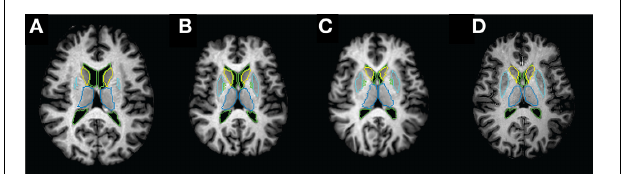
FIGURE 1 | Example axial slices of atlas and subject T1 weighted MR image and the boundaries of their ROI labels at each registration step. (A) Original atlas image and atlas ROIs; (B) atlas image and ROIs after linear AIR transformation; (C) atlas image and ROIs after AIR and LDDMM transformations; (D) subject image and subject